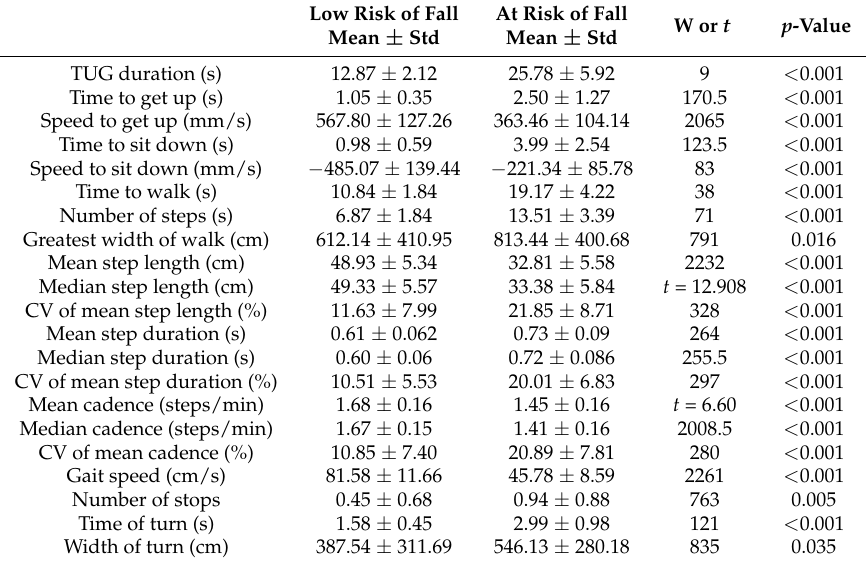
Table 4. Statistically significant differences between the “At risk of fall” ( ≥ 13.5 s on the TUG test) and the “Low risk of fall” ( < 13.5 s on the TUG test) group for automatically extracted